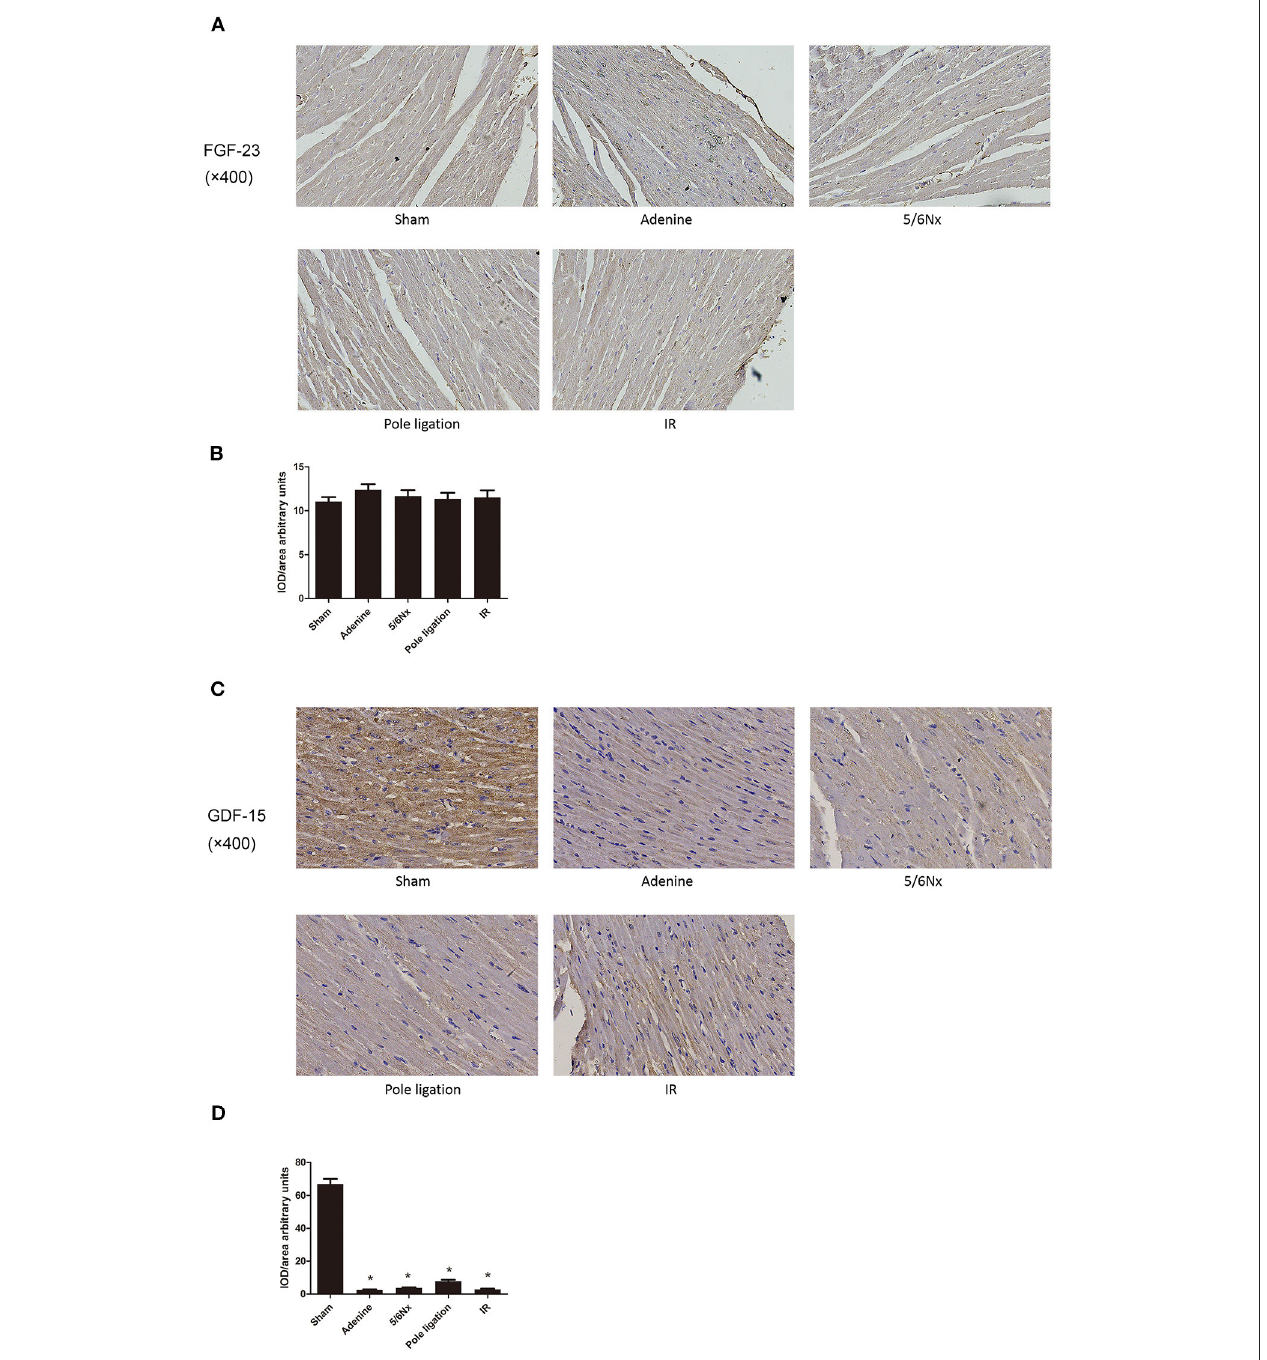
FIGURE 6 | Comparisons of myocardial FGF-23 and GDF-15 protein expression. (A) Representative immunohistochemical staining of FGF-23. (B) Relative values of FGF-23 optical density according to groups. (C) Representative immunohistochemical staining of GDF-15. (D) Relative values of GDF-15 optical density according to groups. * P < 0.001, vs.